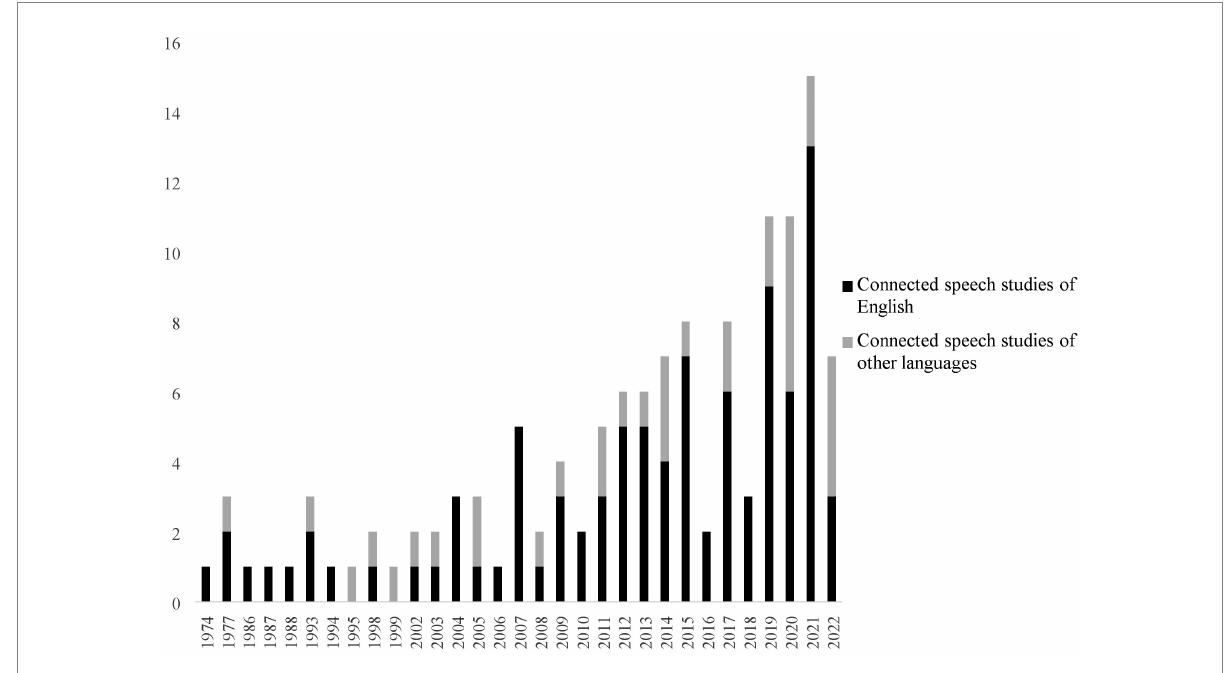
FIGURE 2 The number of reviewed articles of connected speech processing of